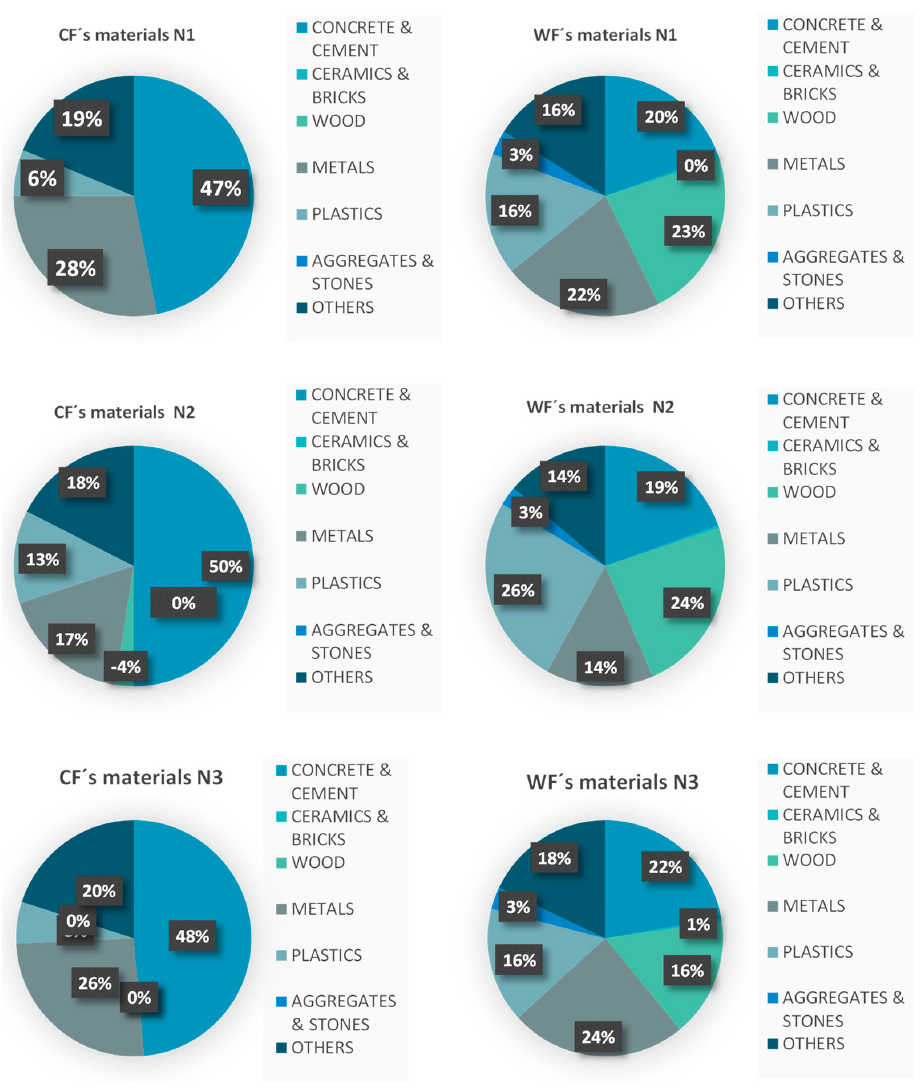
Figure 7. Carbon and water footprint of case studies by material family.